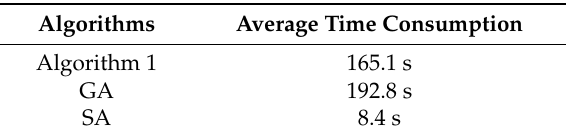
Table 3. The Average Time Consuming of the Three Algorithms.